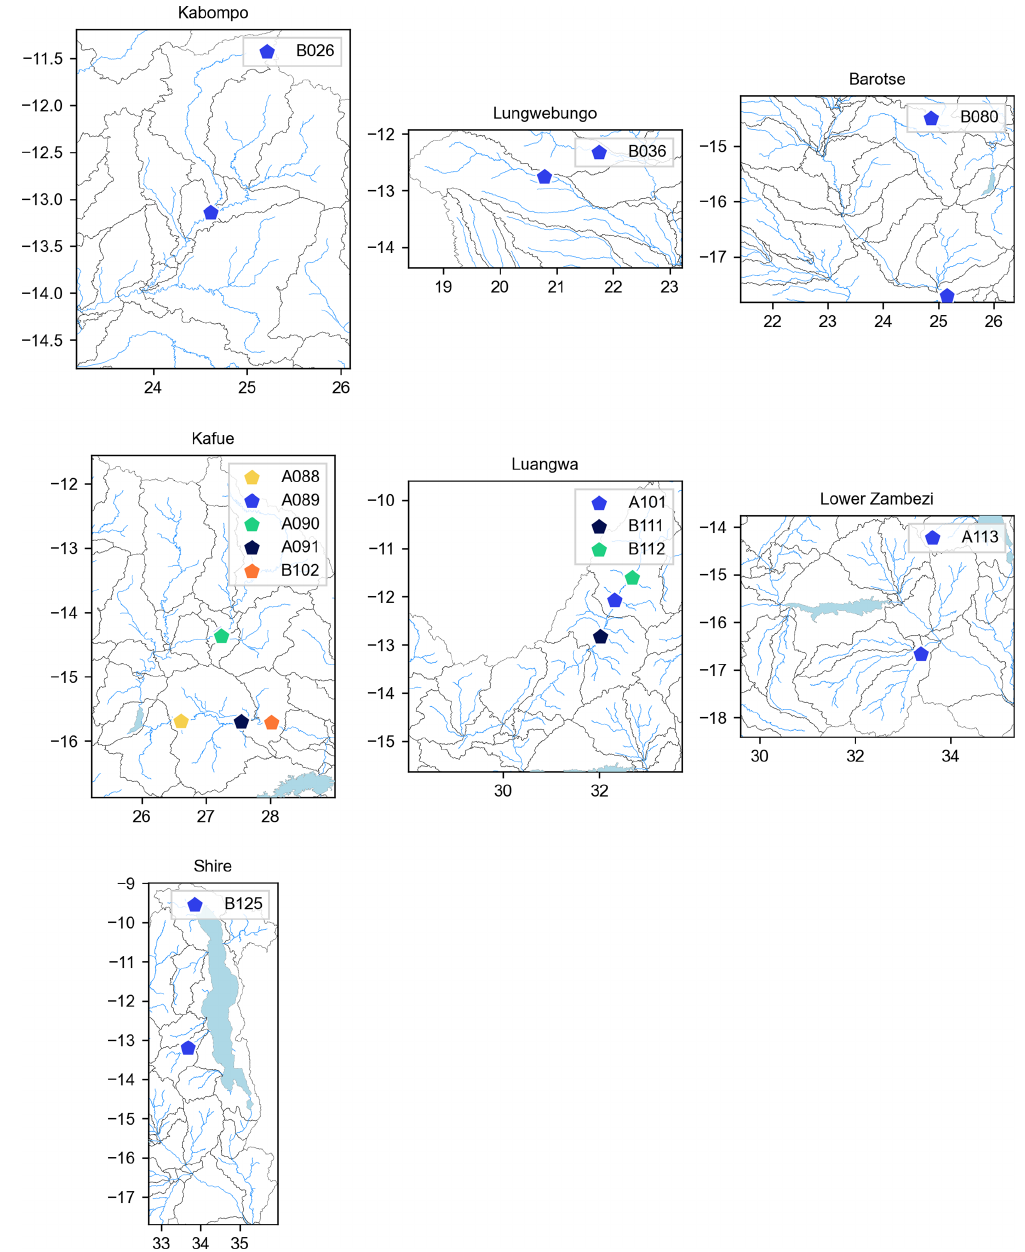
Figure A2. S3A and S3B VSs improved by the 3 x window extension in the GPOD processing